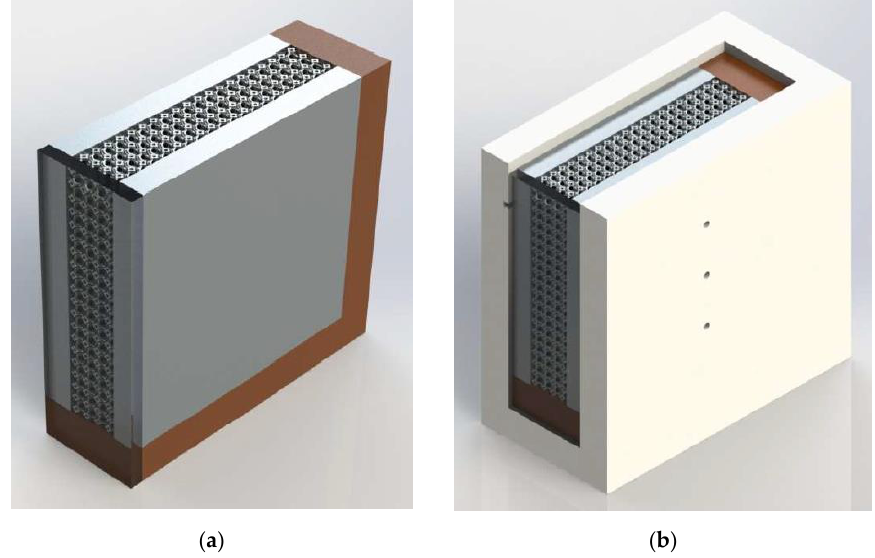
Figure 3. ( a ) Structure with bakelite plates and glass window; ( b ) entire module inside the Teflon case.